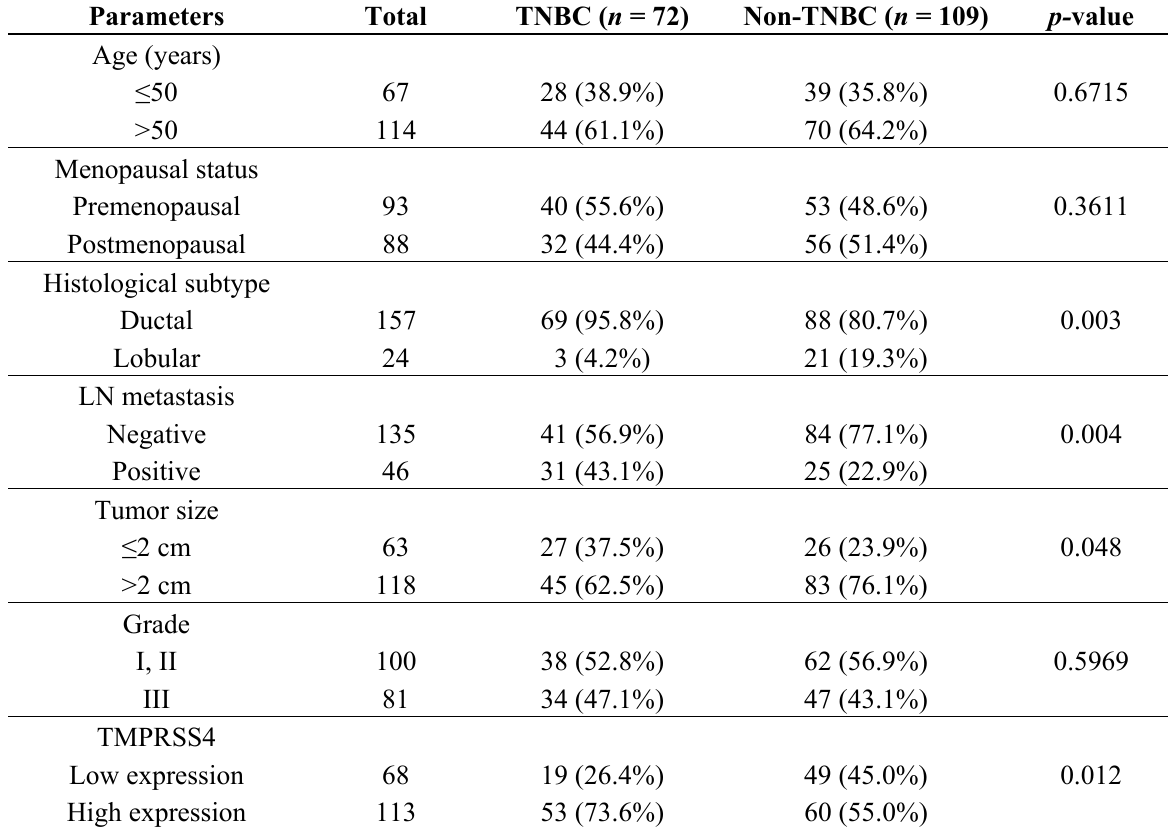
Table 1. Clinical characteristics of breast cancer